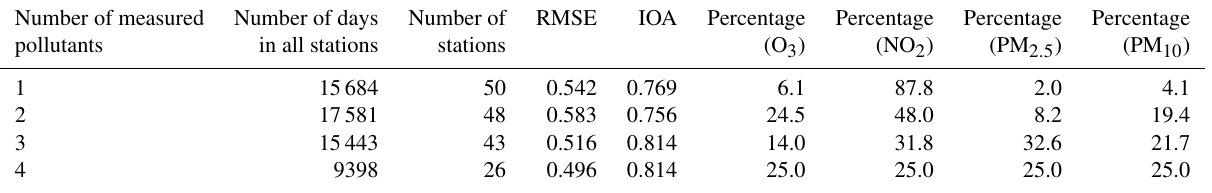
Table 3. Comparing observed and modelled DAQI based on the number of measured pollutants in stations. Number of measured